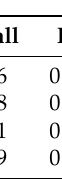
Table 1. Spatial